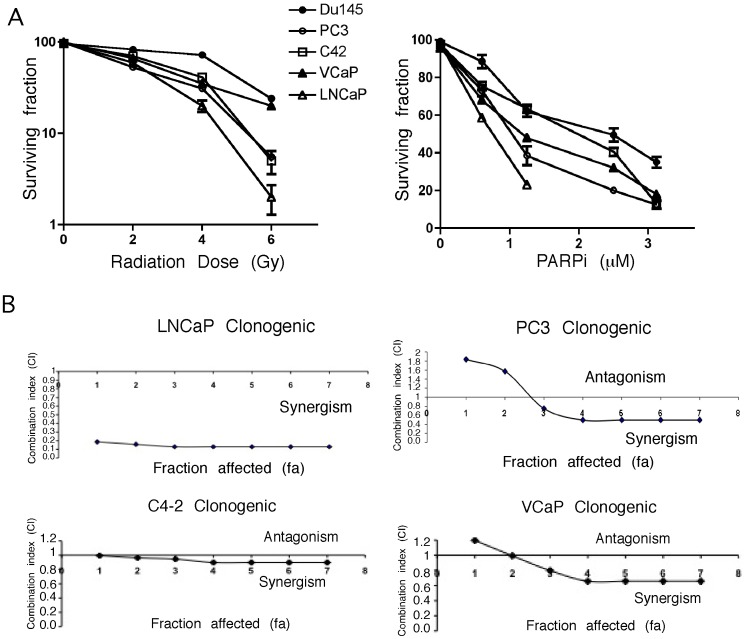
Decreased clonogenic survival of PCa cells exposed to radiation and rucaparib.
A, Radiation and rucaparib dose response in PC3, C4-2, DU145, VCaP and LNCaP cells was established by clonogenic cell survival assays. Left panels indicate the response to radiation, those on the right to rucaparib. B, Synergistic effect of the combination of radiation and rucaparib on clonogenic survival in LNCaP, PC3, C4-2, and VCaP cells, where CI <1 represents synergy and CI >1 an antagonistic interaction between the two treatments. Error bars represent SD of mean (n = 3).